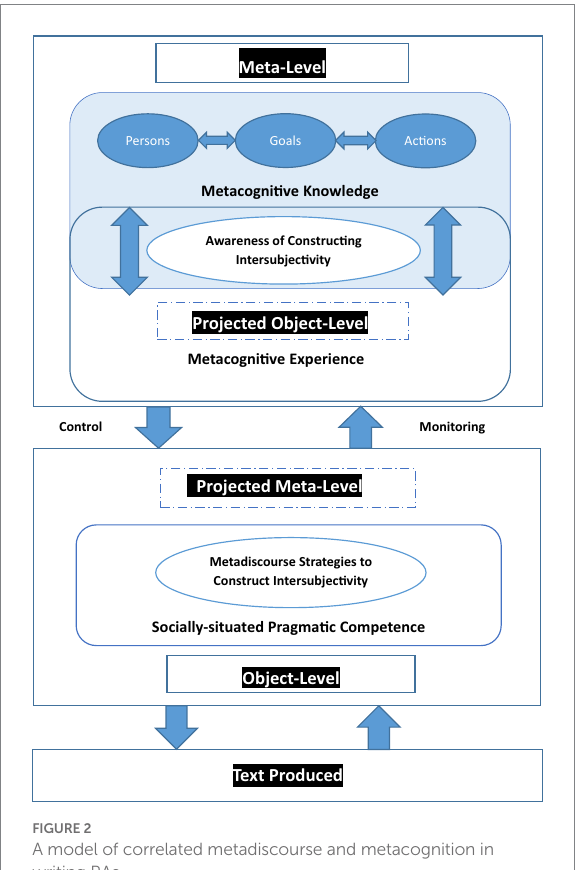
FIGURE 2 A model of correlated metadiscourse and metacognition in writing